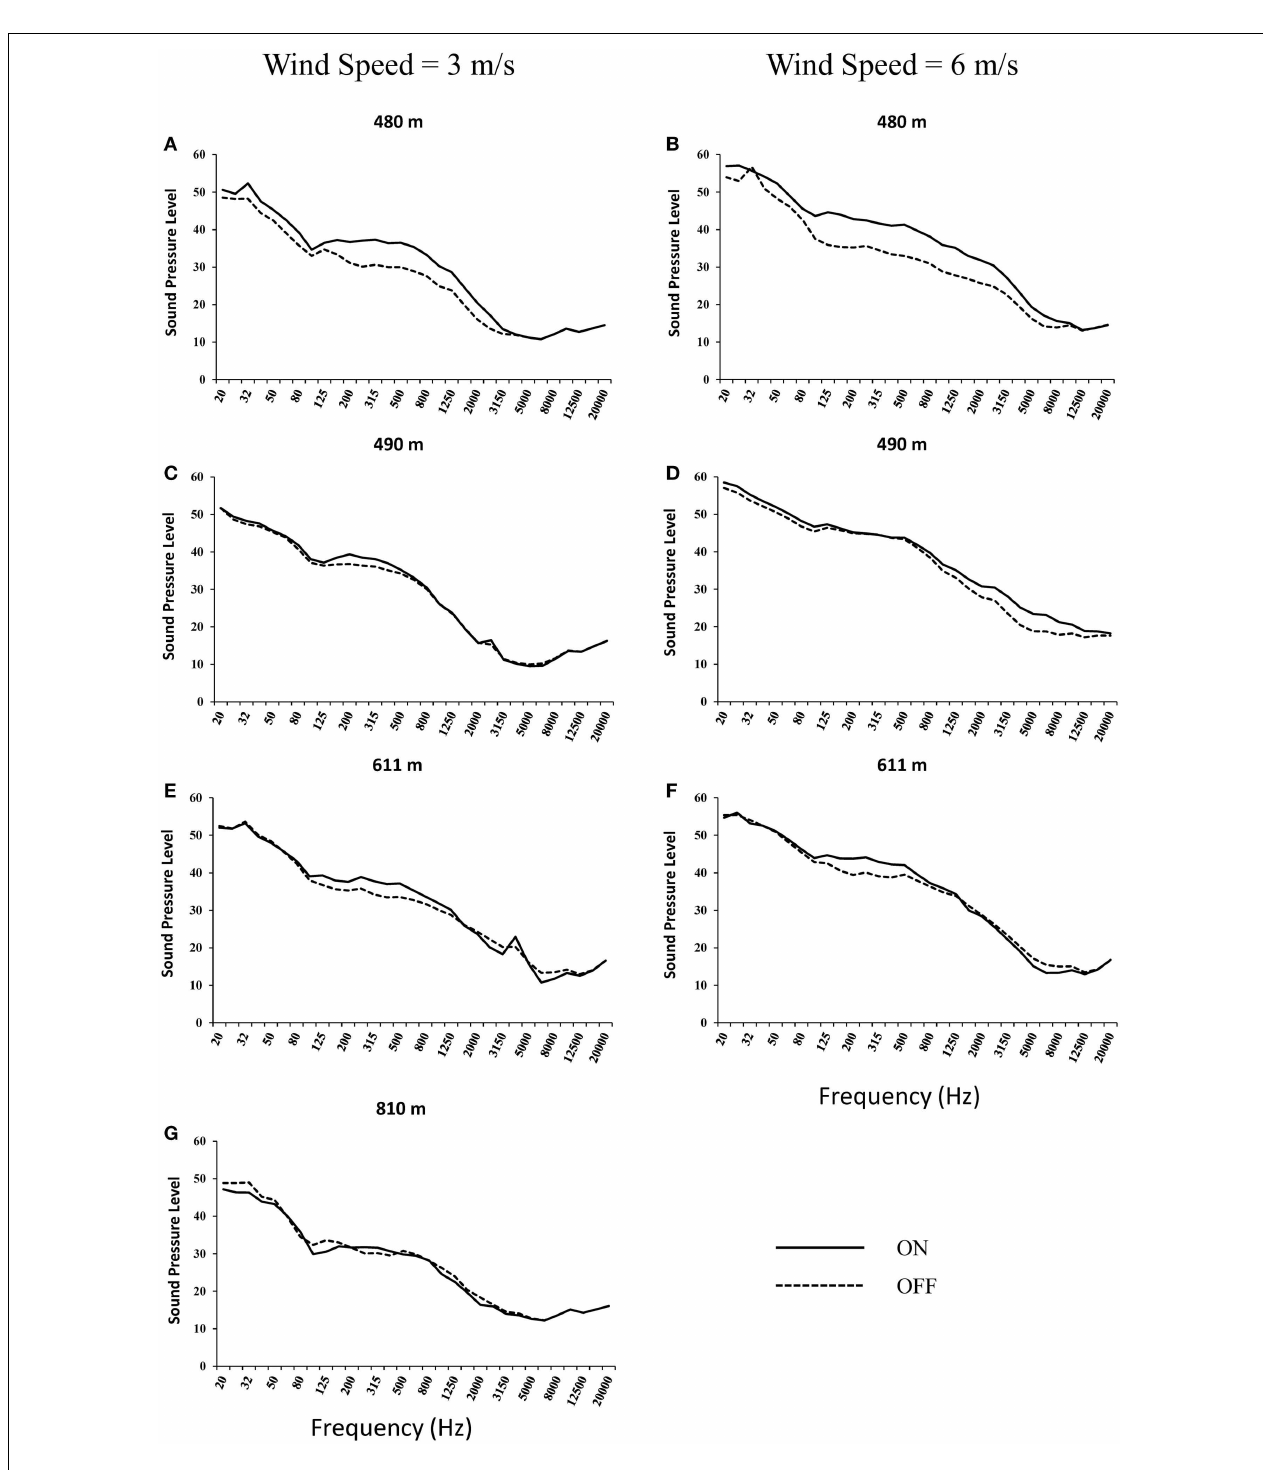
consistent. From these results, it is evident that during wind tur- bine operation, the increased sound levels that began in the LFN spectrum, at approximately 160 Hz and continued to 1000 Hz,